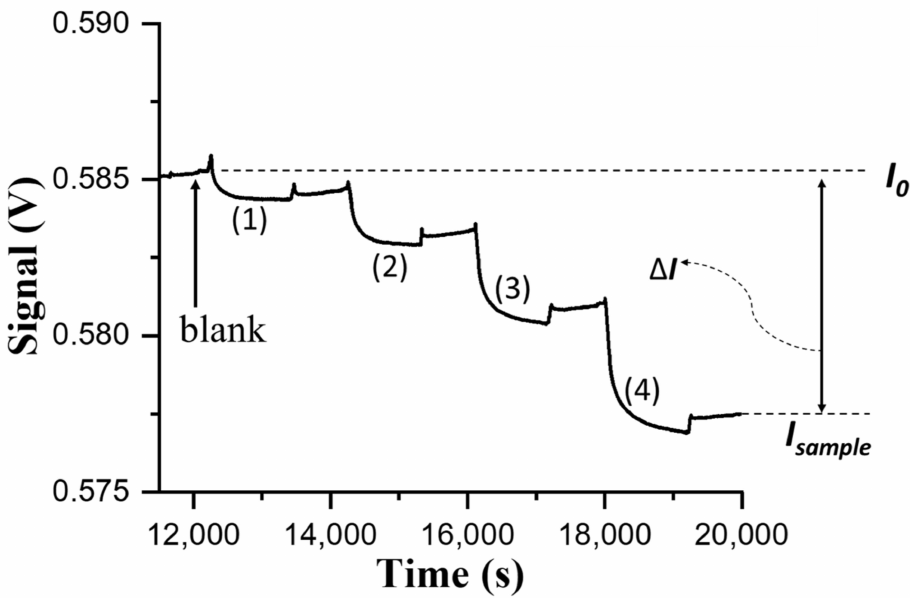
Figure 3. The sensorgram obtained by sequentially injecting diluted filtrate samples of NNV-infected larvae homogenate with dilution factor of (1) 320, (2) 160, (3) 80, and (4)